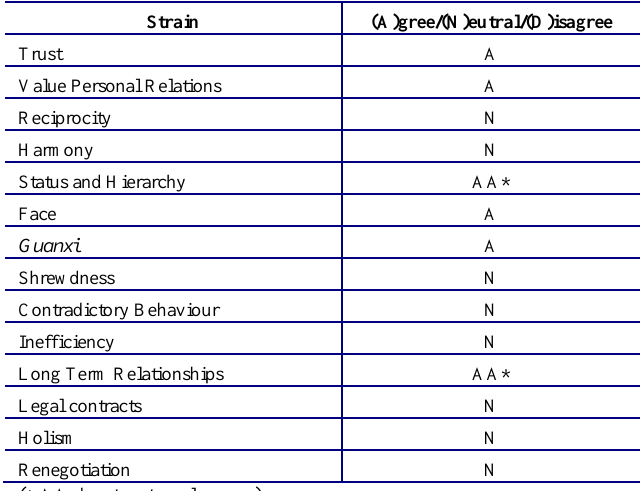
(* AA denotes strongly agree) With the high number of neutral outcomes, there is no overwhelming evidence to show those SA negotiators’ perceptions of Chinese negotiation styles and behaviours are different from those held by Western business